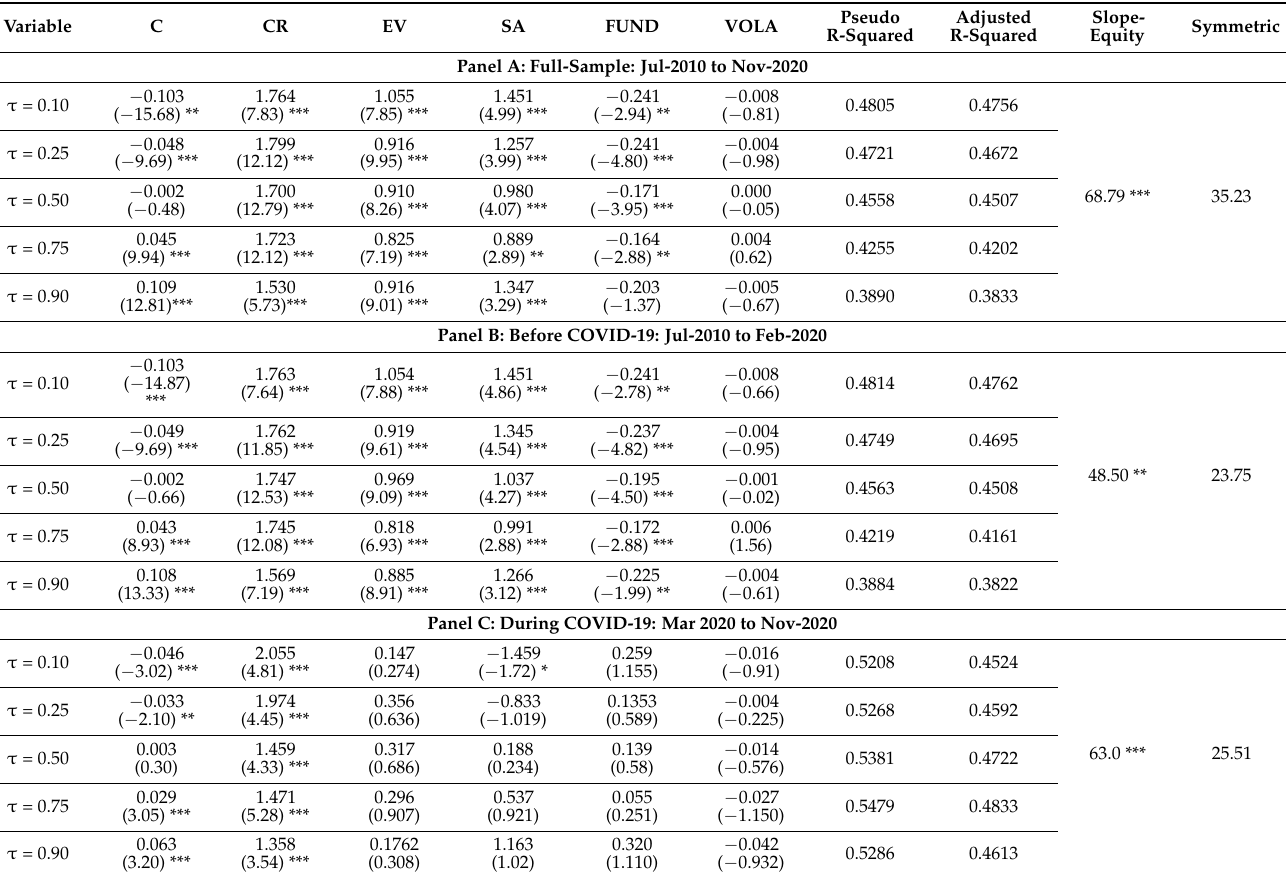
Table 3. QR-Estimation of